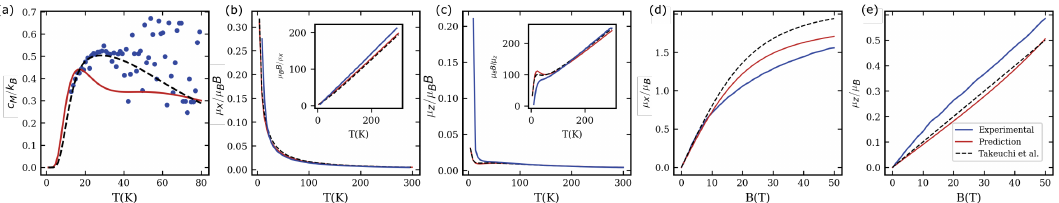
Figure 8: CNN application to CeAgSb . Comparison of experimental target data 2 and CNN predictions for CeAgSb . Experimental target data is shown in blue. The 2 theoretical results are obtained within the single-ion approximation using the CF parameters in Tab. 1 obtained from CNN (red) and from Takeuchi et al. [ 43 ] (black dashed). Both fits are characterized by MSE =